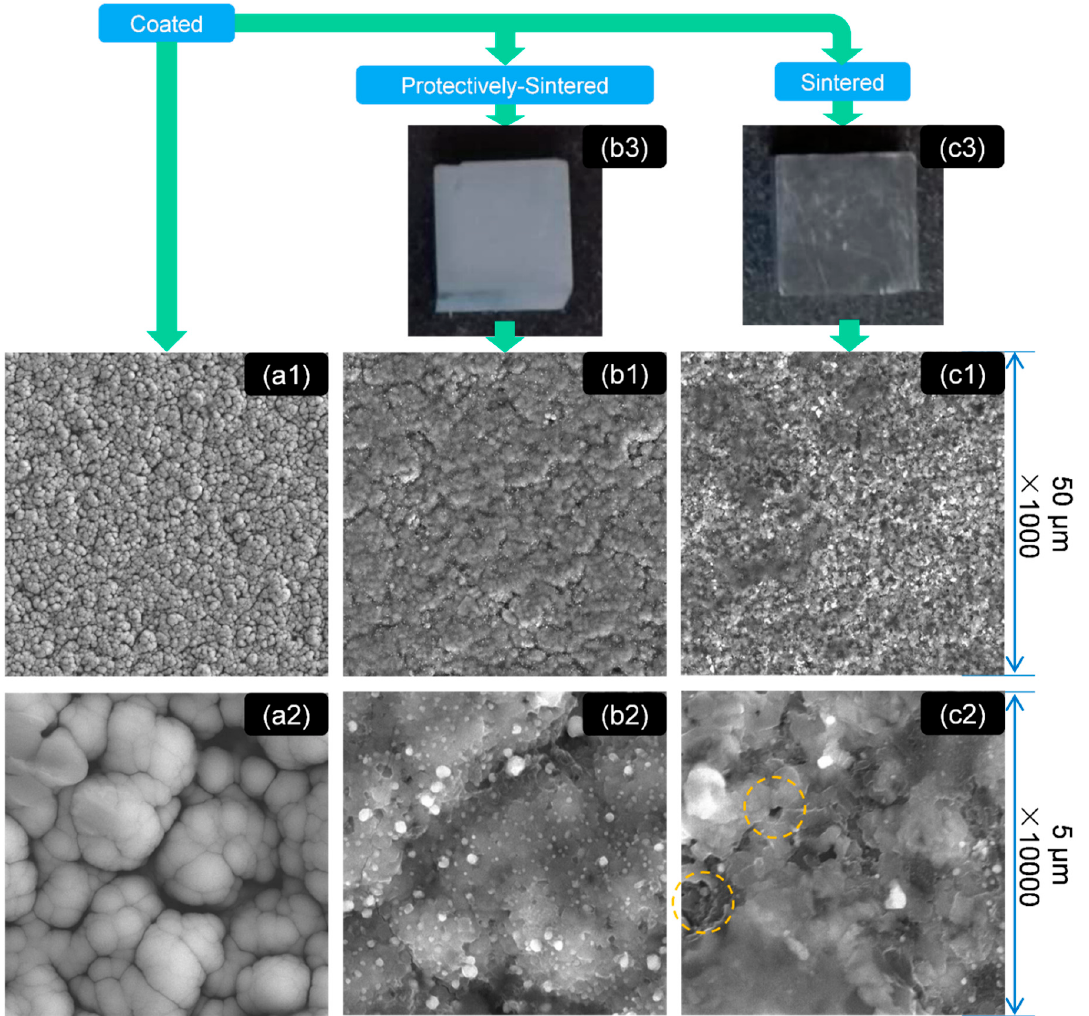
Figure 1. The morphology as shown by field emission scanning electron microscopy (FE-SEM) of the samples at different scales: group ( a ) the SiC substrate coated with Ni-Ti only, ( a1 ) ×1000, ( a2 ) ×10000; group ( b ) the protectively-sintered (sintered together with the oxygen-absorbed material) surface of ( a ), ( b1 ) ×1000, ( b2 ) ×10000; group ( c ) the normally-sintered surface of ( a ), ( c1 ) ×1000, ( c2 ) ×10000; ( b3 ) the optical surface quality of the protectively-sintered substrates; and ( c3 ) the optical surface quality of the sintered substrates.